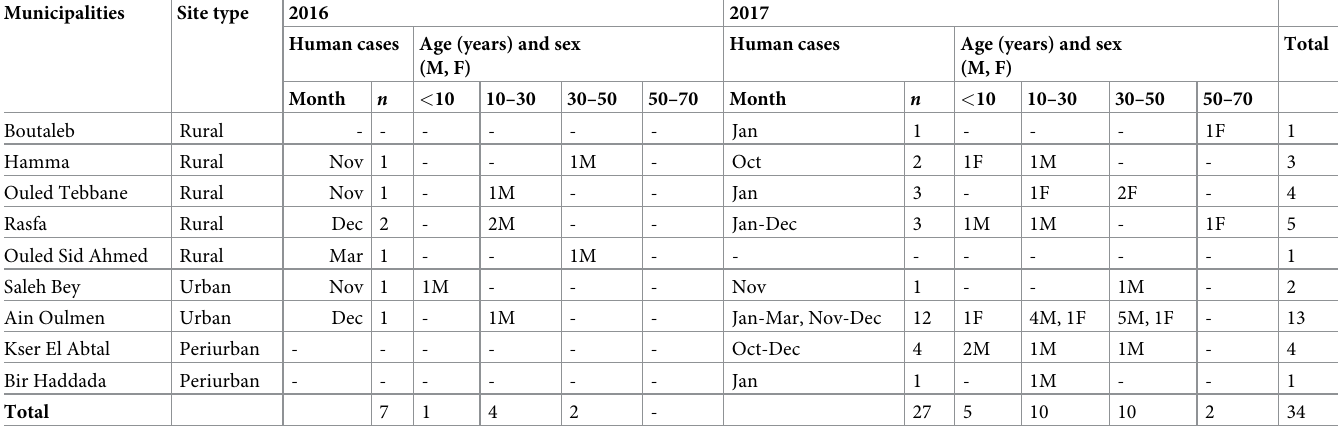
-, not available; M, male; F,